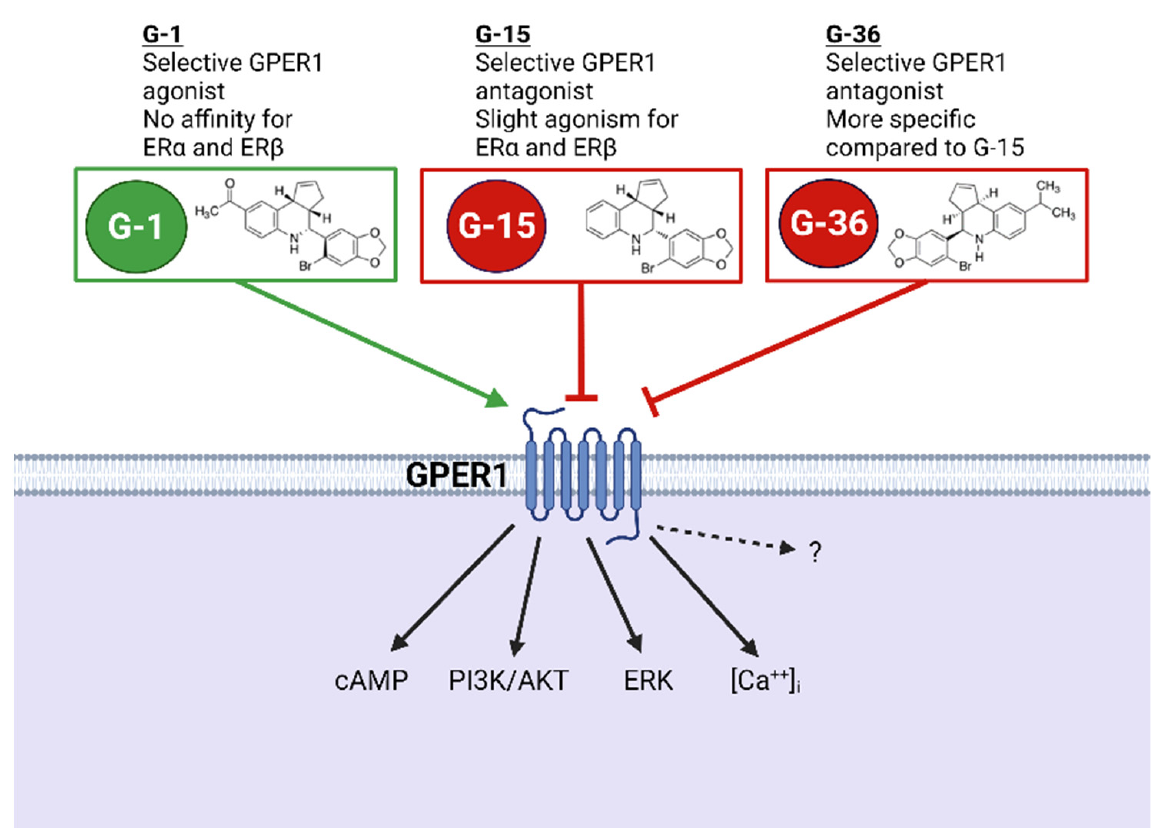
Figure 2. Pharmacological tools to study GPER1 function. Abbreviations: GPER1—G protein-cou- pled estrogen receptor 1. ER α /ER β —Estrogen receptor alpha/beta. CAMP—Cyclic adenosine mono- phosphate. PI3K—Phosphoinositide 3-kinase. AKT—Protein kinase B. ERK—Extracellular signal- regulated kinases. [Ca 2+ ] i —Intracellular calcium. Created with BioRender.com accessed on 23 Feb- ruary 2022.